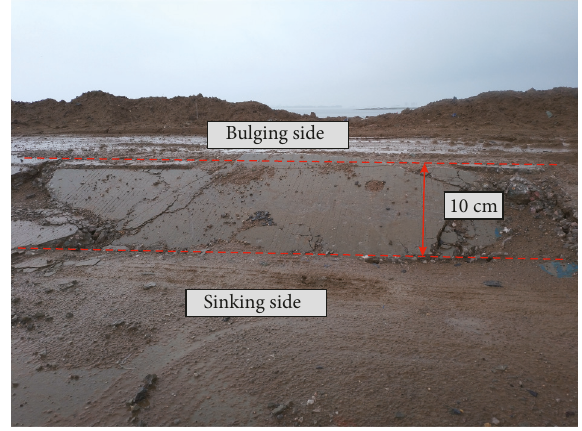
Figure 7: Meteorism deformation in the top of upstream coffer- dam during flood decline